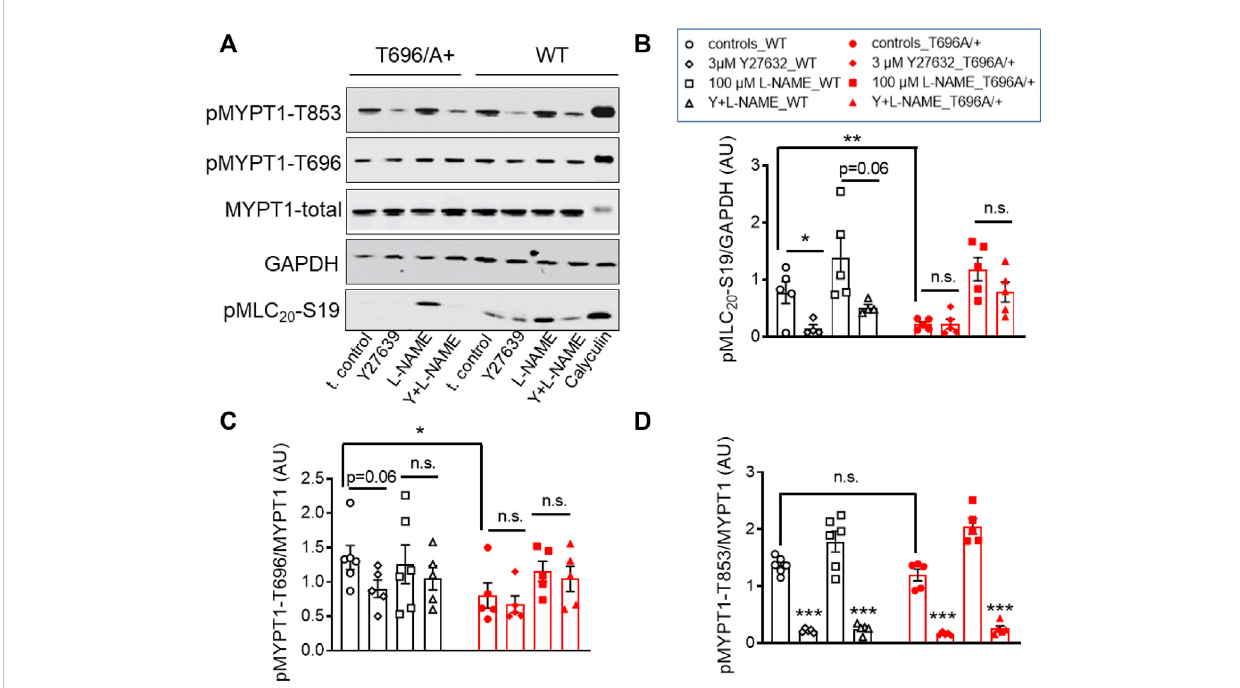
FIGURE 5 EffectofROKinhibitiononMLC 20 -S19,MYPT1-T696,andMYPT1-T853insenescentbasilararteriesfromWTandMYPT1-T696A/+mice. (A) Original westernblotsandstatisticalevaluationofthephosphorylationof (B) MLC 20 -S19(pMLC 20 ),andMYPT1at (C) T696 ( pMYPT1-T696)and (D) T853(pMYPT1- T853)ins-BAsfromWTandMYPT1-T696A/+miceundercontrolconditions(nostimulations),andafterpreincubationwith3 μ mol/LY27632,100 μ mol/l L-NAME or Y27632 plus L-NAME. Data are represented as ratio of pMYPT1-T696/853 toward MYPT1-total or MLC 20 -S19 toward GAPDH ( n =